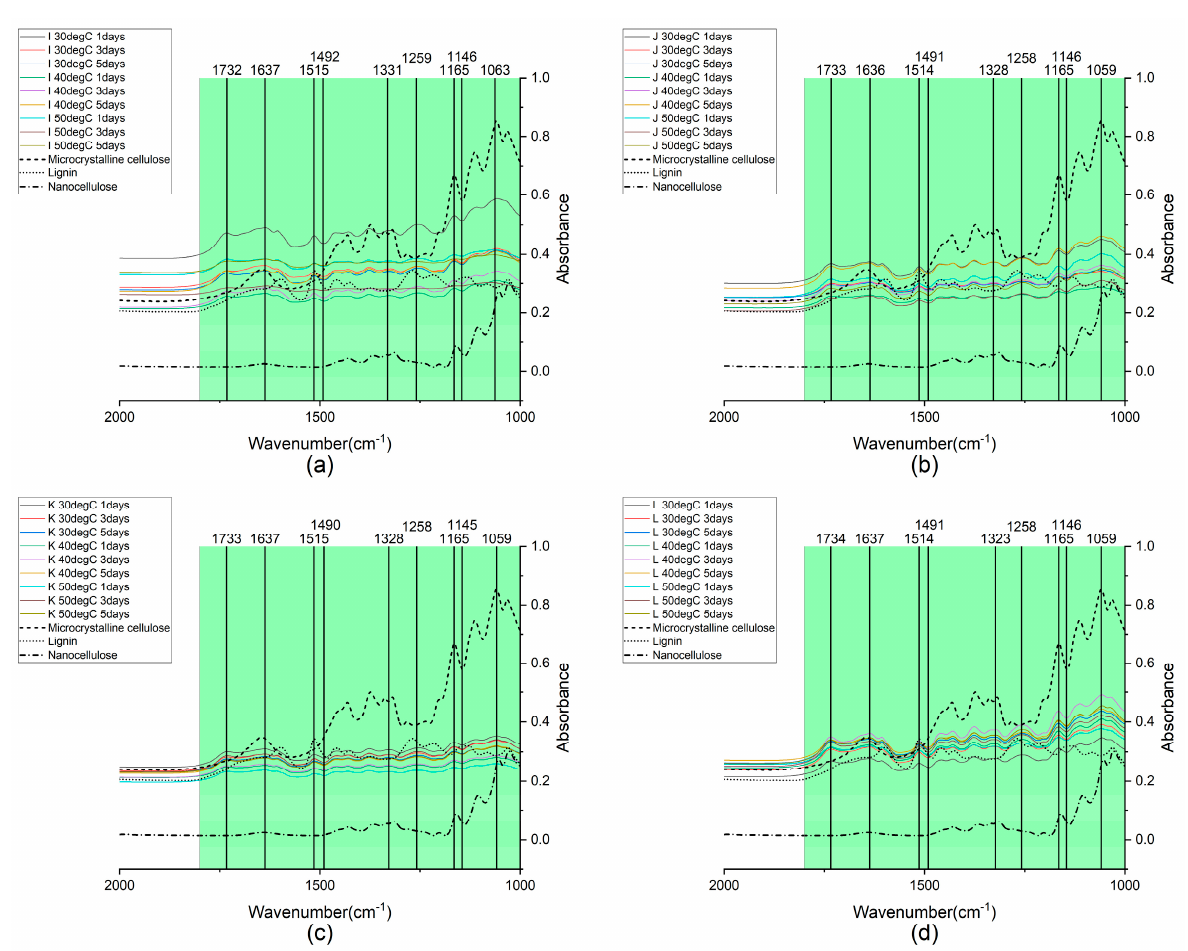
Figure 12. FTIR spectra of stem samples pretreated at 75 °C at varying incubation temperatures and